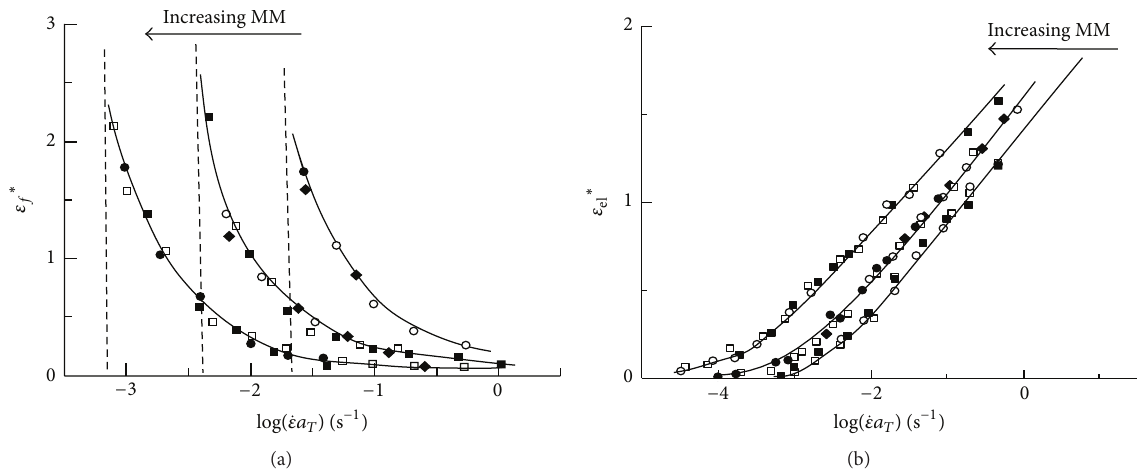
Figure 1: Strain rate dependencies of irreversible (flow) deformations 𝜀 𝑓∗ (a) and recoverable (rubbery) deformations 𝜀 el ∗ (b) at extension and break for polybutadienes. 𝑎 𝑇 = 𝜂(𝑇)/𝜂 0 . Different symbols correspond to various temperatures (authors’ data).